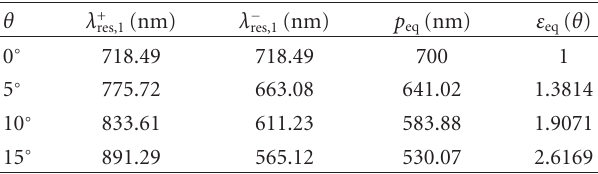
Table 1: Resonant wavelengths corresponding to the excitation of the SPP modes over the air-metal interface of the array of gold stripes with p = 700nm and corresponding parameters for the equivalent